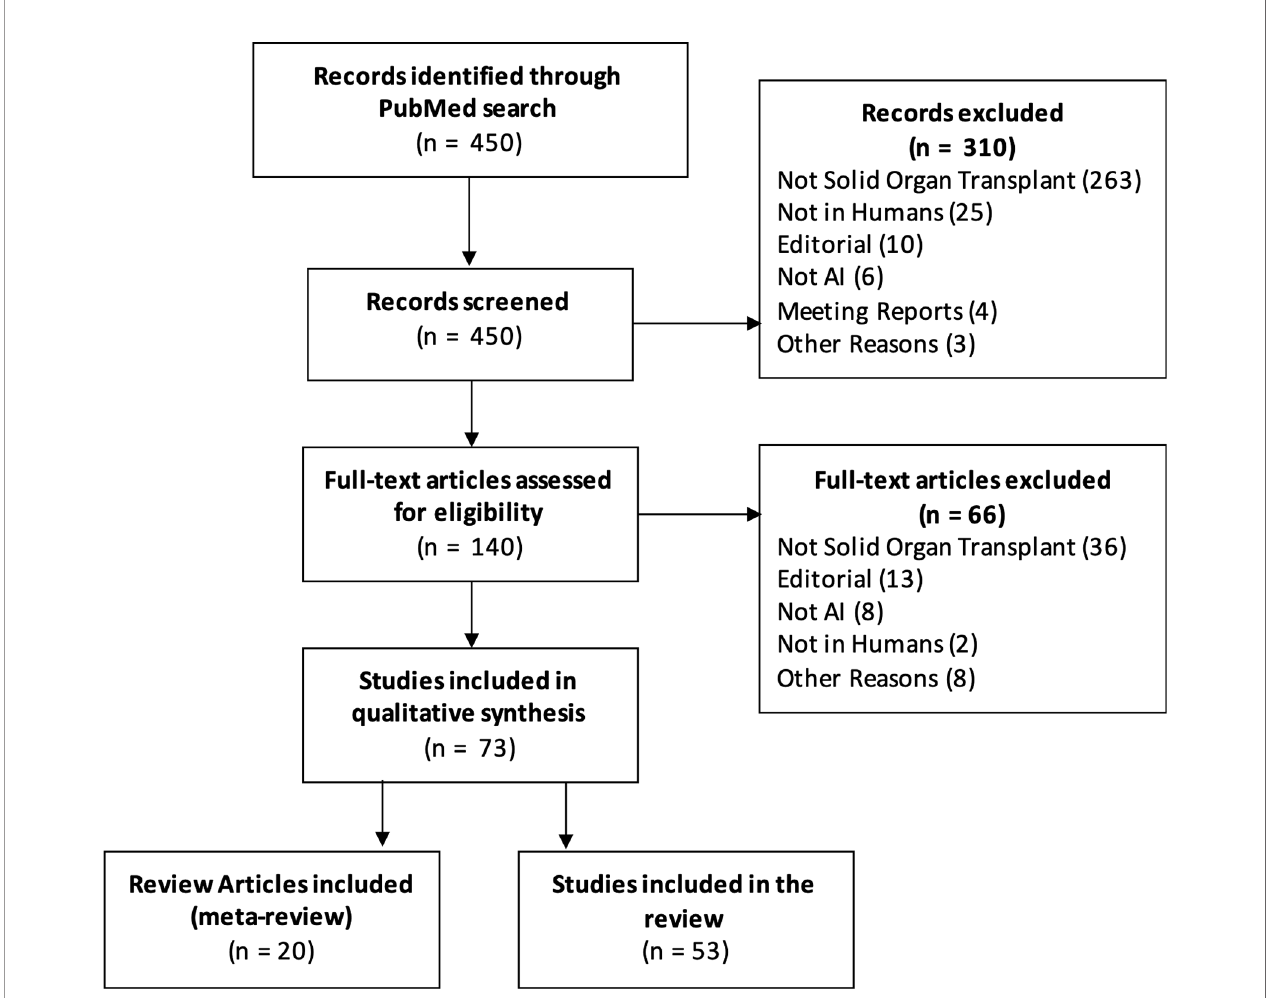
FIGURE 1 | PRISMA Diagram detailing the selection and screening of records included in the